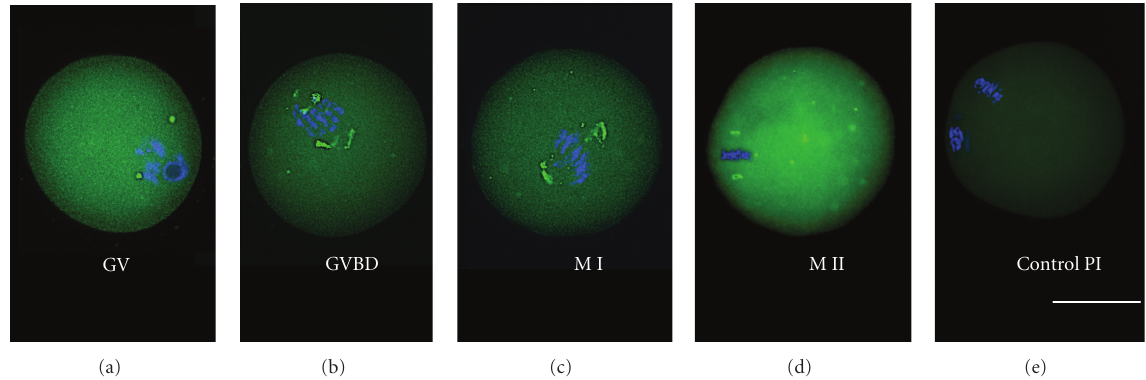
Figure 3: Immunofluorescence localization of TCTP with anti-XlTCTP antibody in mouse maturing oocytes. GV: prophase I-arrested oocyte, GVBD: the beginning of maturation, MI and MII: oocytes in MI and MII phase of meiosis, respectively, control PI: control MII oocyte stained with the preimmune serum. XlTCTP antibody stains PCM in all stages of maturing mouse oocytes. DNA (blue) stained with DAPI. Bar is equal to 40 μ m.